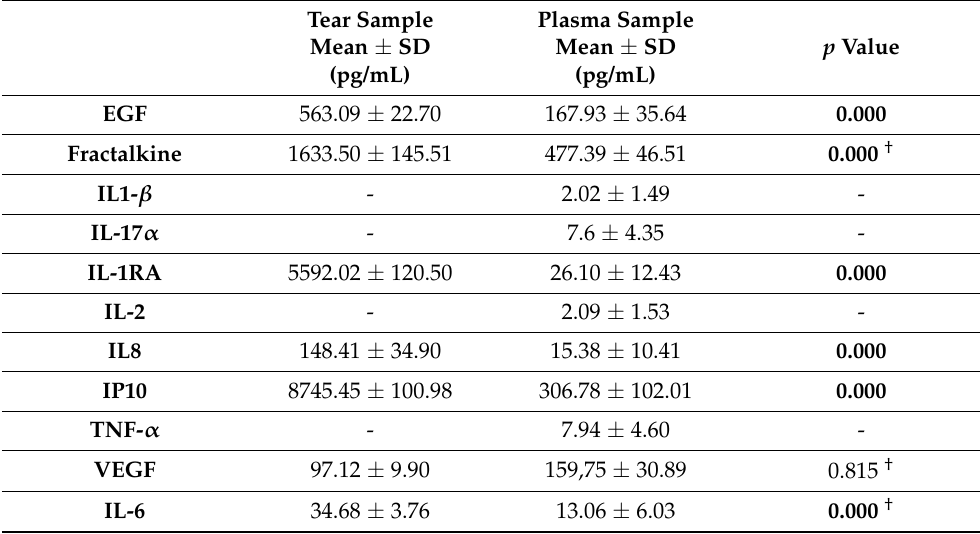
Table 4. Comparison of cytokine concentrations in tears and plasma in the active phase.